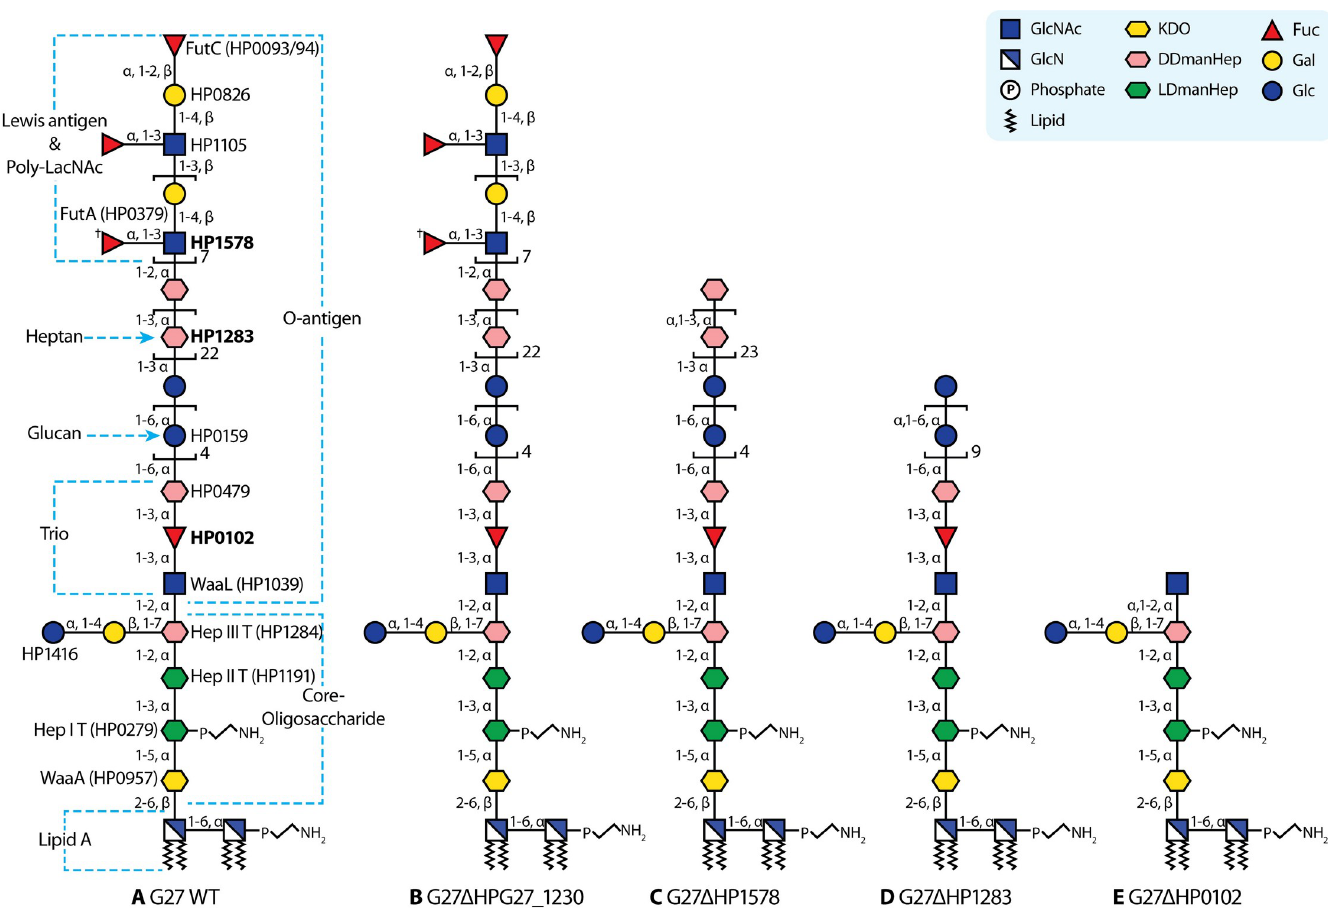
Fig 1. LPS structures in G27 wild-type and mutants. ( A ): Summary of glycosyltransferases underlying LPS biosynthesis in G27; ( B) : G27 Δ HPG27_1230 LPS is similar to that of G27 wild-type; (C) : G27 Δ HP1578 LPS lacks the distal Lewis antigens but has a longer heptan (at least 24 repeating units); (D) : G27 Δ HP1283 LPS lacks the Lewis antigens and the heptan, but has a longer glucan (at least 9 repeating units); (E) : G27 Δ HP0102 LPS lacks the Lewis antigens, the heptan and the glucan. The O- antigen is not necessary composed of repeating poly Le x , it can also be poly-LacNAc with fewer Lewis epitopes. Glycosidic linkages are annotated from the non-reducing